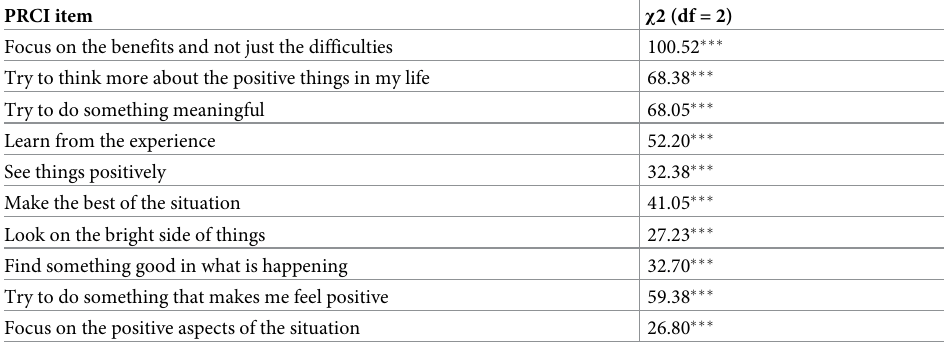
Table 1. Chi-square goodness of fits statistics comparing positive reappraisal coping, negative responses and neu- tral responses to PRCI items. PRCI